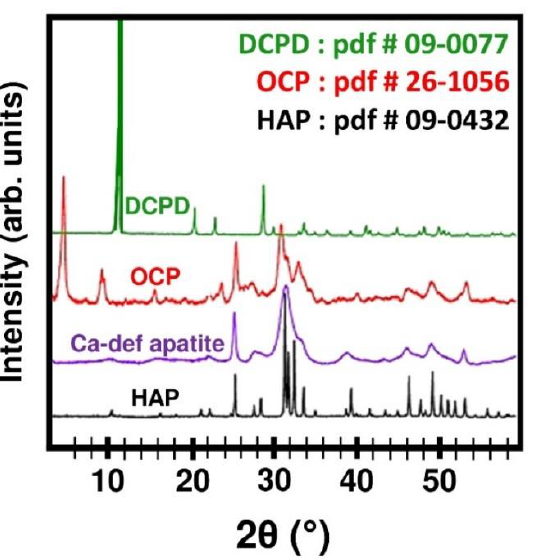
Figure 5. XRD patterns of electrodeposited calcium phosphate coatings. Reprinted and adapted with permission from Ref. [112]. Copyright 2013 Christophe Drouet.